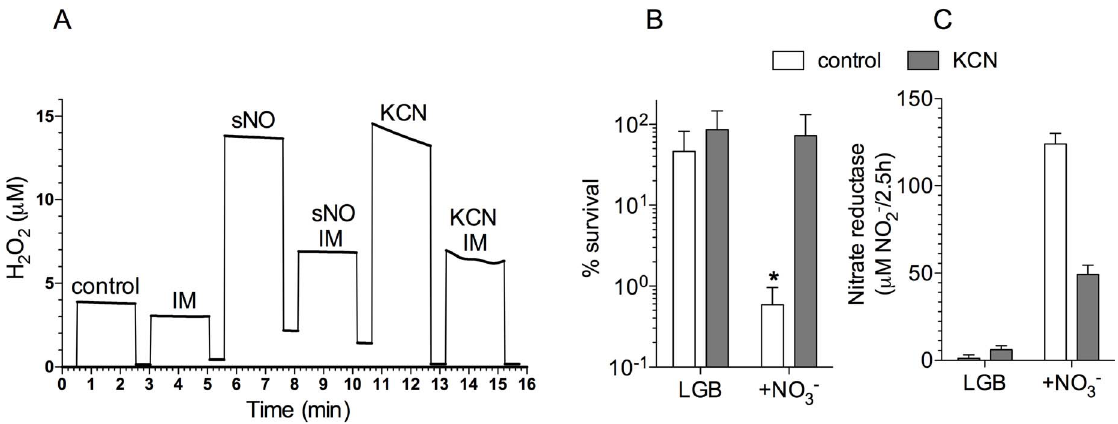
Figure 5. Effect of imipenem and nitrosative stress on H 2 O 2 synthesis. The production of H 2 O 2 by B. pseudomallei diluted to OD 600 of 0.5 was measured polarographically (A). Some of the specimens were treated with 12.5 m g/ml imipenem (IM), and where indicated the bacterial cells were treated with 100 m M spermine NONOate (sNO) or 500 m M KCN. Untreated cells are shown as controls. The H 2 O 2 probe was washed with fresh LB broth between individual specimens. The data are representative of 3 observations collected on 3 separate days. The killing of anaerobic B. pseudomallei by 50 m g/ml IM was tested in LBG broth in the presence or absence of 50 mM NO 3 2 (B). p , 0.01 compared to the KCN-treated group. Nitrate reductase activity was monitored by measuring the accumulation of NO 2 2 by the Griess reaction (C).